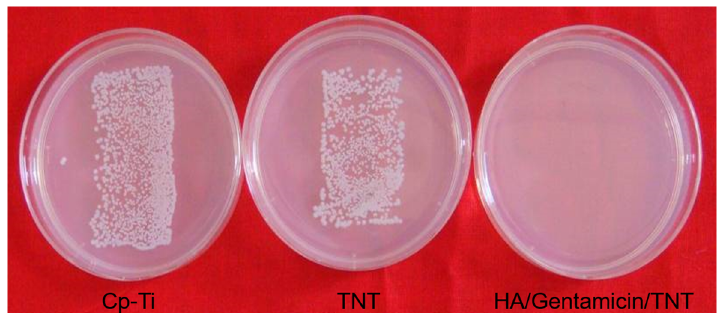
Figure 8. Infection rates were observed to be at 100% for the bare Ti group and 92% for the TNT group. A 0% infection rate was observed for the HA/gentamicin/TNT group. There was a significantly reduced infection rate in the HA/gentamicin/TNT group compared to the TNT and bare Ti groups.